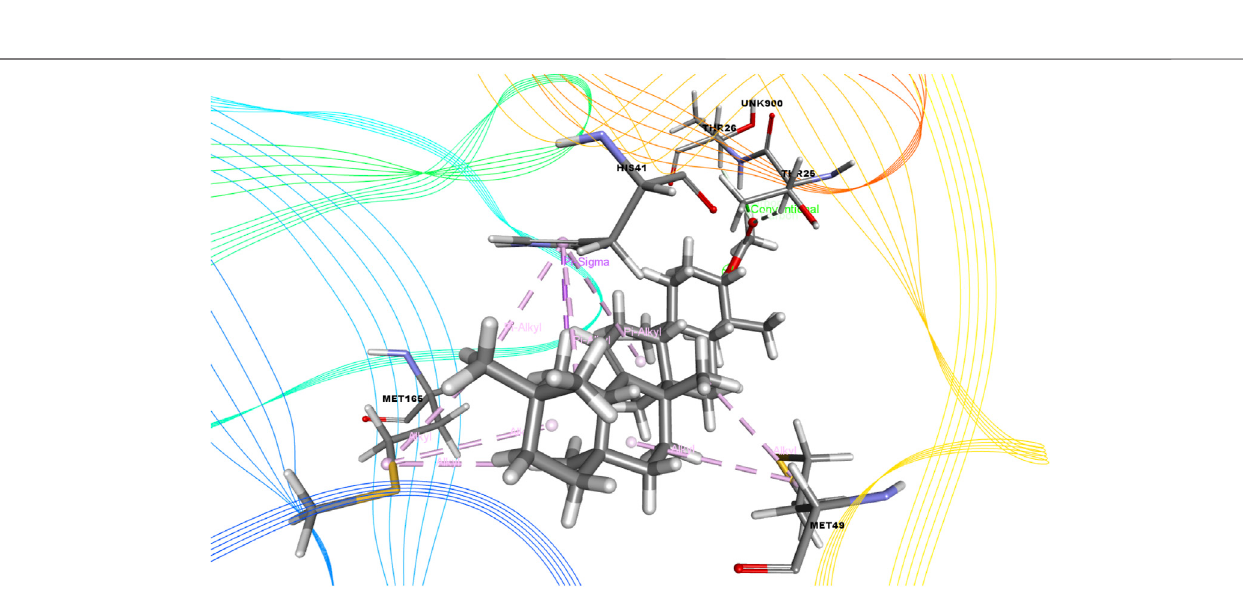
FIGURE 5 | 3D interactions of Olean-12-en-3-ol, acetate, (3.beta.)- with the active site of SARS-CoV-2 main protease (PDB ID: 6W63).